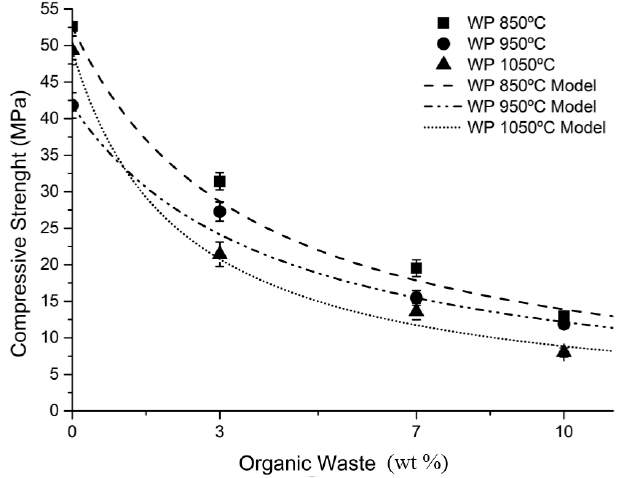
Figure 9. Relationship between compressive strength and wt % of organic matter. Table 6. Coefficient a, coefficient of correlation, and standard error.